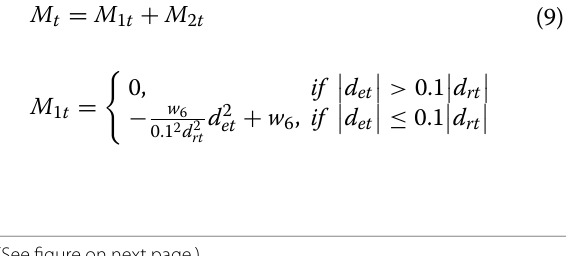
s)(See figure on next Fig. 4 Simulation results for RL vs. LQR ( L